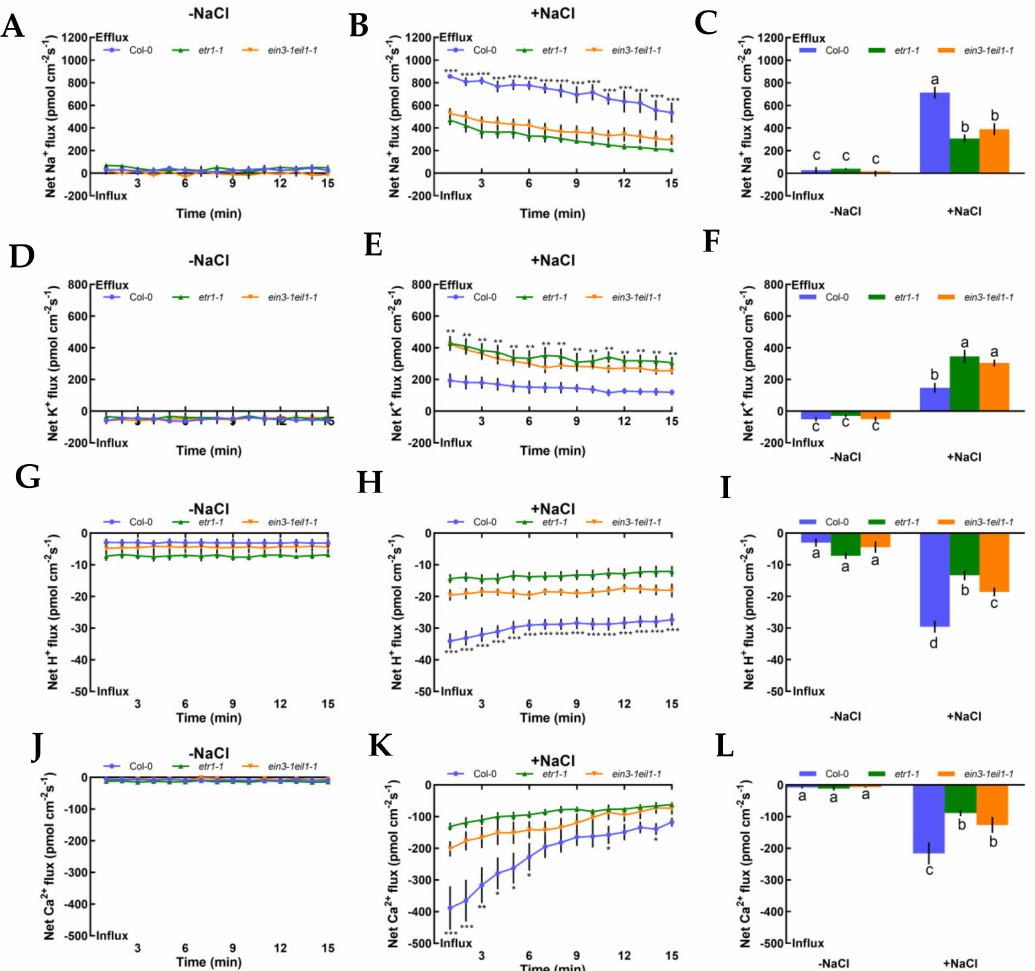
Figure 2. E ff ects of short-term NaCl stress (100 mM, 12 h) on the steady-state Na + , K + , H + , and Ca 2 +